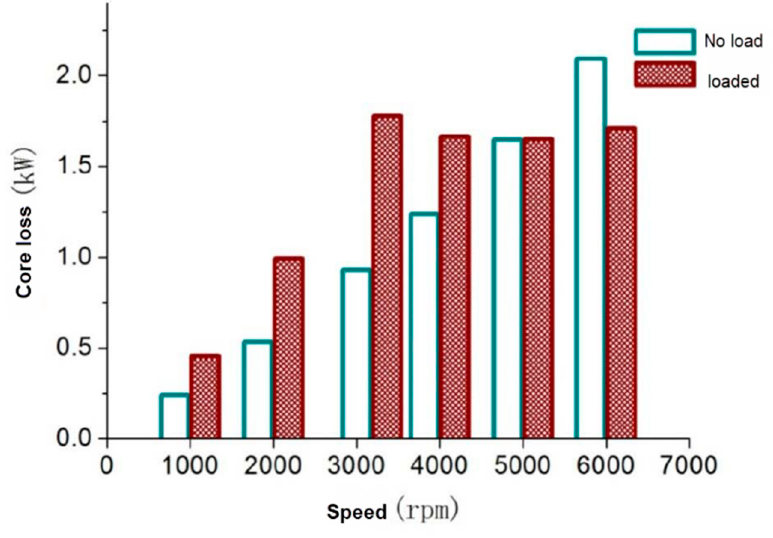
Figure 11. No-load loss and load loss of the motor at di ff erent speeds.